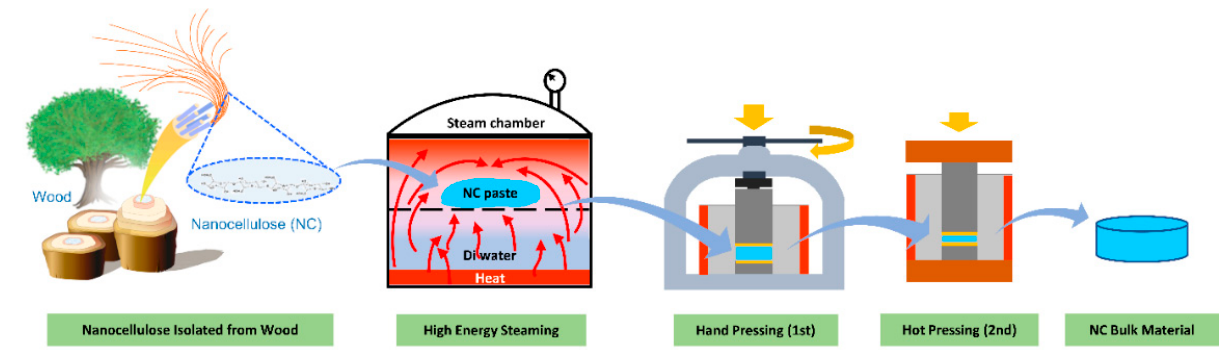
Figure 1. Schematic of nanocellulose bulk material fabrication process.